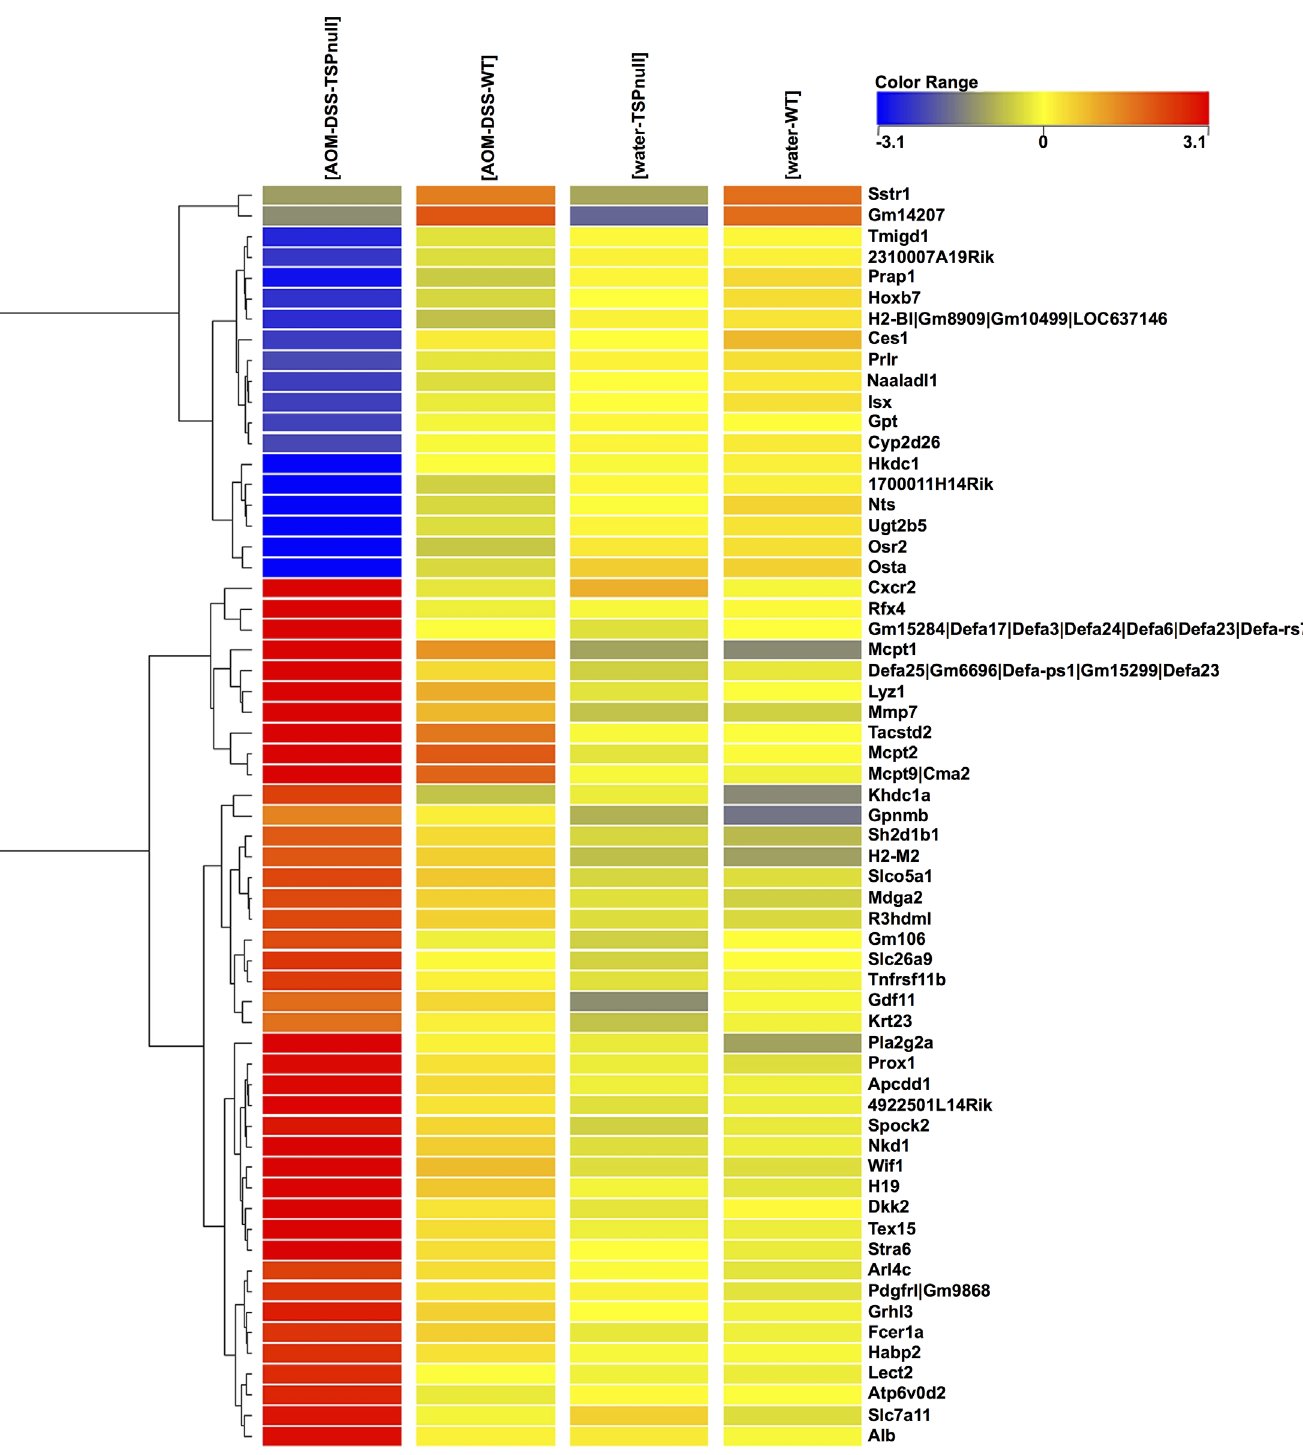
PLOS ONE | DOI:10.1371/journal.pone.0139918 October 13,